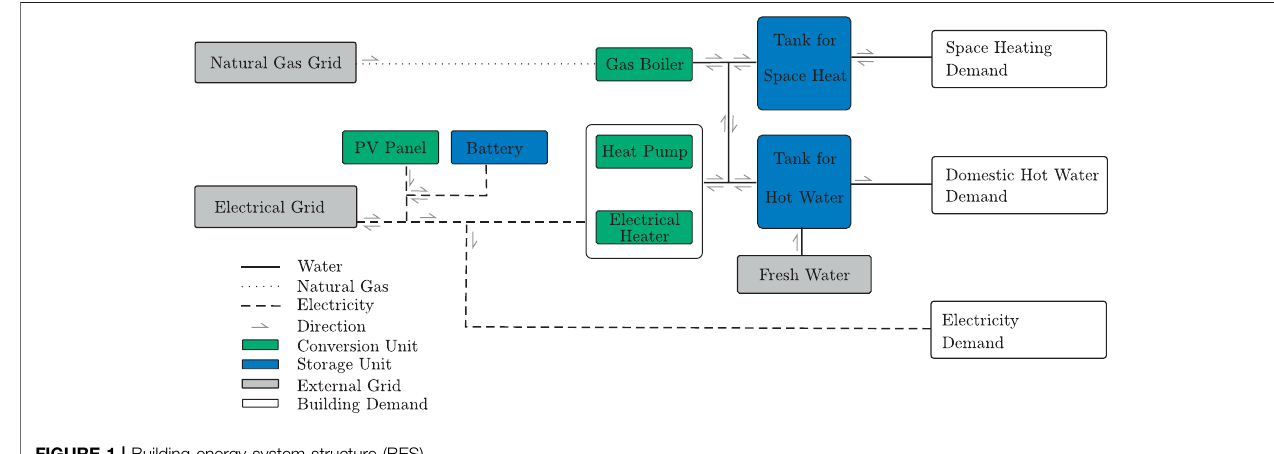
FIGURE 1 | Building energy system structure